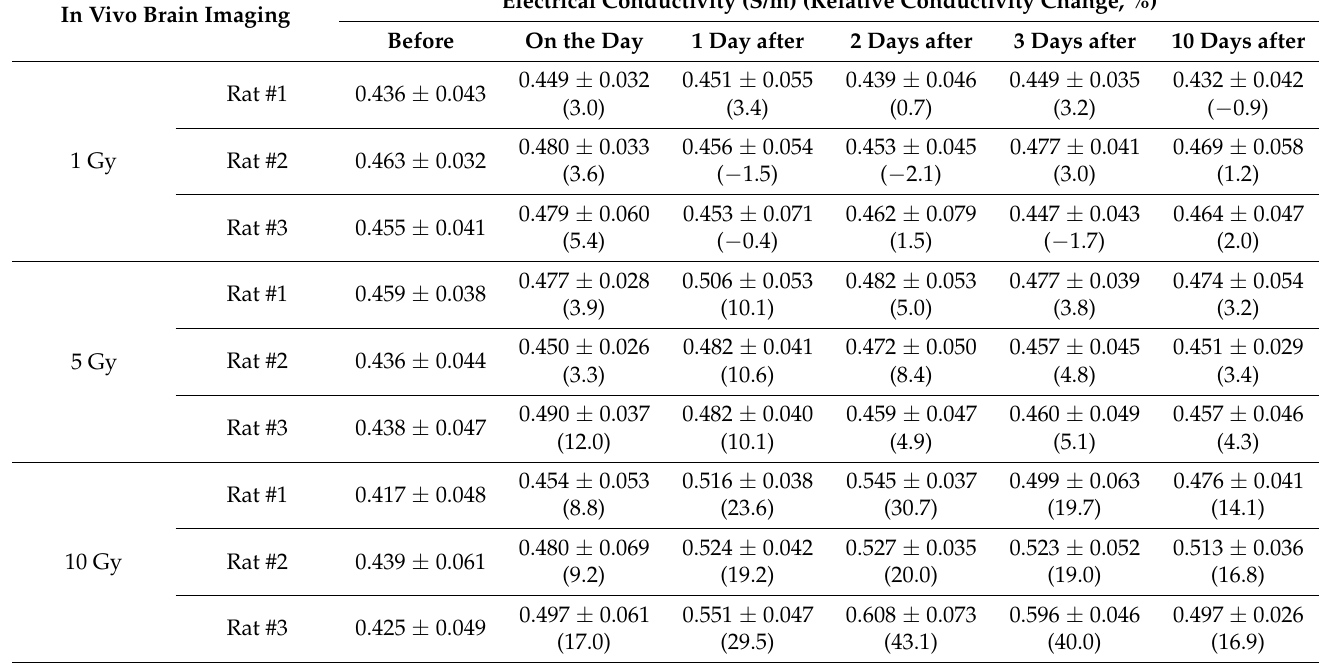
Table 2. Summary of electrical conductivity and relative conductivity change (in parentheses) from in vivo mouse brain imaging. The measured conductivity indicates absolute values of the tissue response at three doses. The relative conductivity change indicates the extent of tissue response to irradiation based on the values of